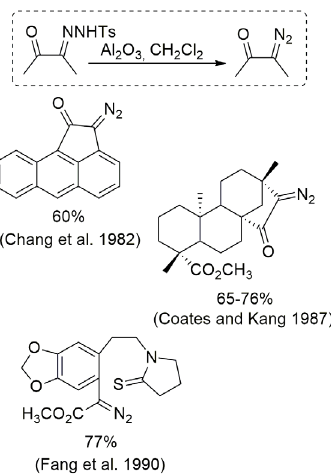
Figure 36 - Examples of Bamford-Stevens reactions to convert carbonyl compounds in diazo derivatives.